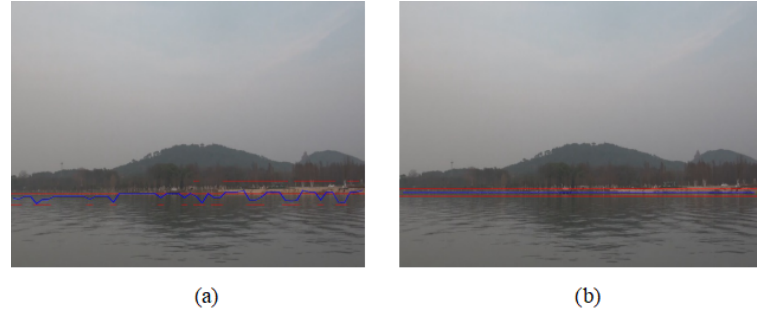
Figure 6. Visual comparisons on detection results by performing Algorithm 1 on a single image with two different scales of WLpeephole (here, blue line shows the estimated waterline, and red line acts as the subline for marking manually the ground truth): ( a ) r = 30 and s = 10, ( b ) r = 60 and s = 30.